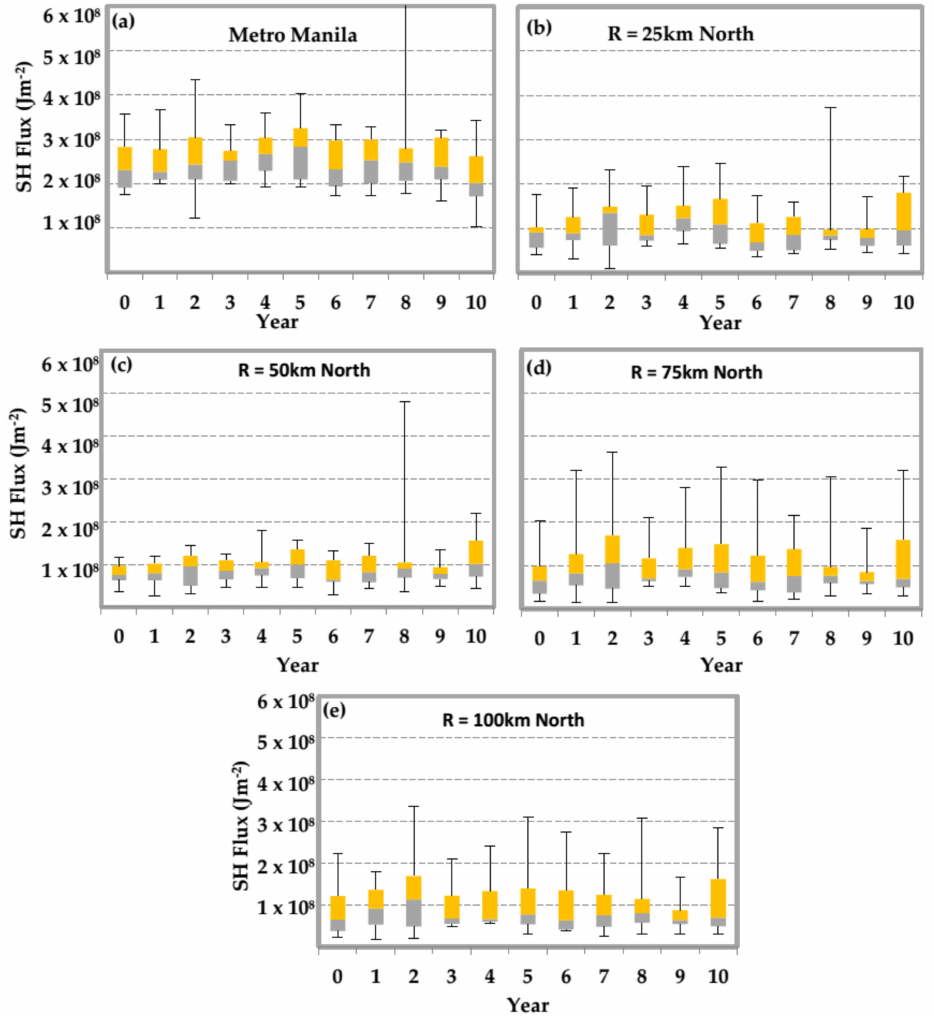
Figure 3. Annual variation of sensible heat (SH) flux of Metro Manila ( a ) and selected places in